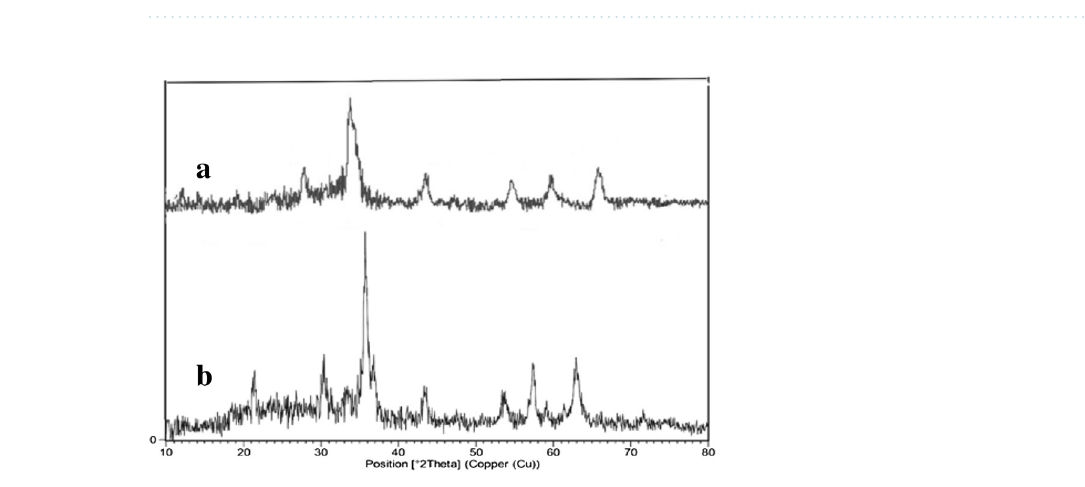
Figure 3. FESEM images of FNASiPPEA ( a and b ), and ( c ) TEM of FNASiPPEA.